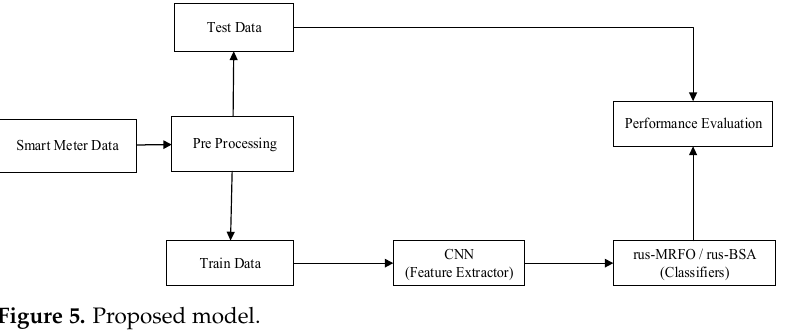
Figure 5. Proposed